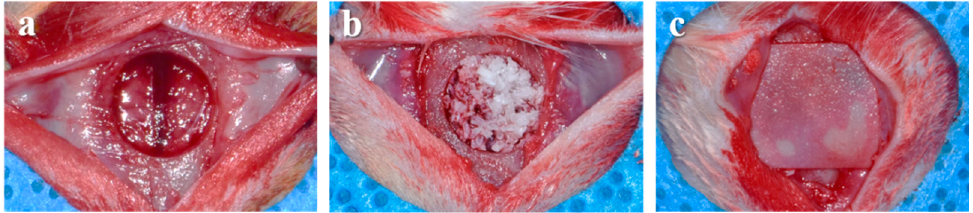
Figure 1. Operative procedures using rat calvarial defect model. ( a ) Created calvarial defect, ( b ) Figure1. Operativeproceduresusingratcalvarialdefectmodel. ( a )Createdcalvarialdefect, ( b )insertion insertion of bone grafts, ( c ) placement of collagen membrane. of bone grafts, ( c ) placement of collagen